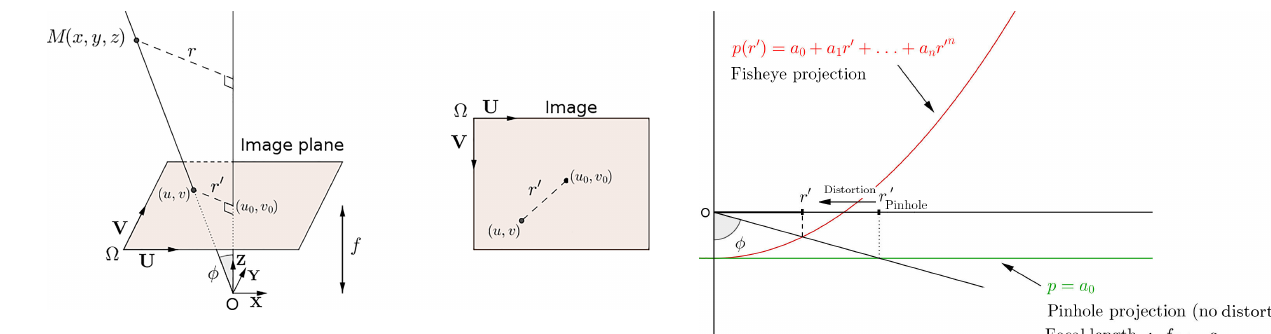
Figure 2. Pinhole projection. Physical point M is projected on (u,v) on the image plane ((cid:127), U , V ) . Camera coordinate system is defined by axis X and Y , which are colinear to U and V , and by axis Z , which is the optical axis . Principal point (u 0 ,v 0 ) is the pro- jection of the optical center O on the image. The radial projected distance on the image is denoted r (cid:48) .